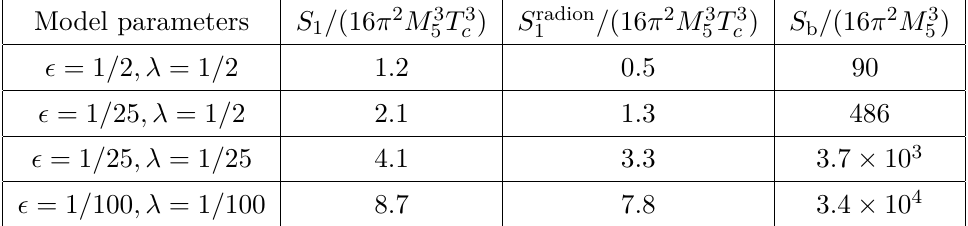
Table 1. Comparison of numerical results of S 1 (eq. (4.2)) and S radion model parameters (cid:15) , λ . To get the concrete number for S radion to ρ h in the first line of eq. (4.3). We also show the full bounce action S b (eq. (4.1)) in the thin-wall limit in terms of S 1 at ( T/T c ) 4 = 1 / 2